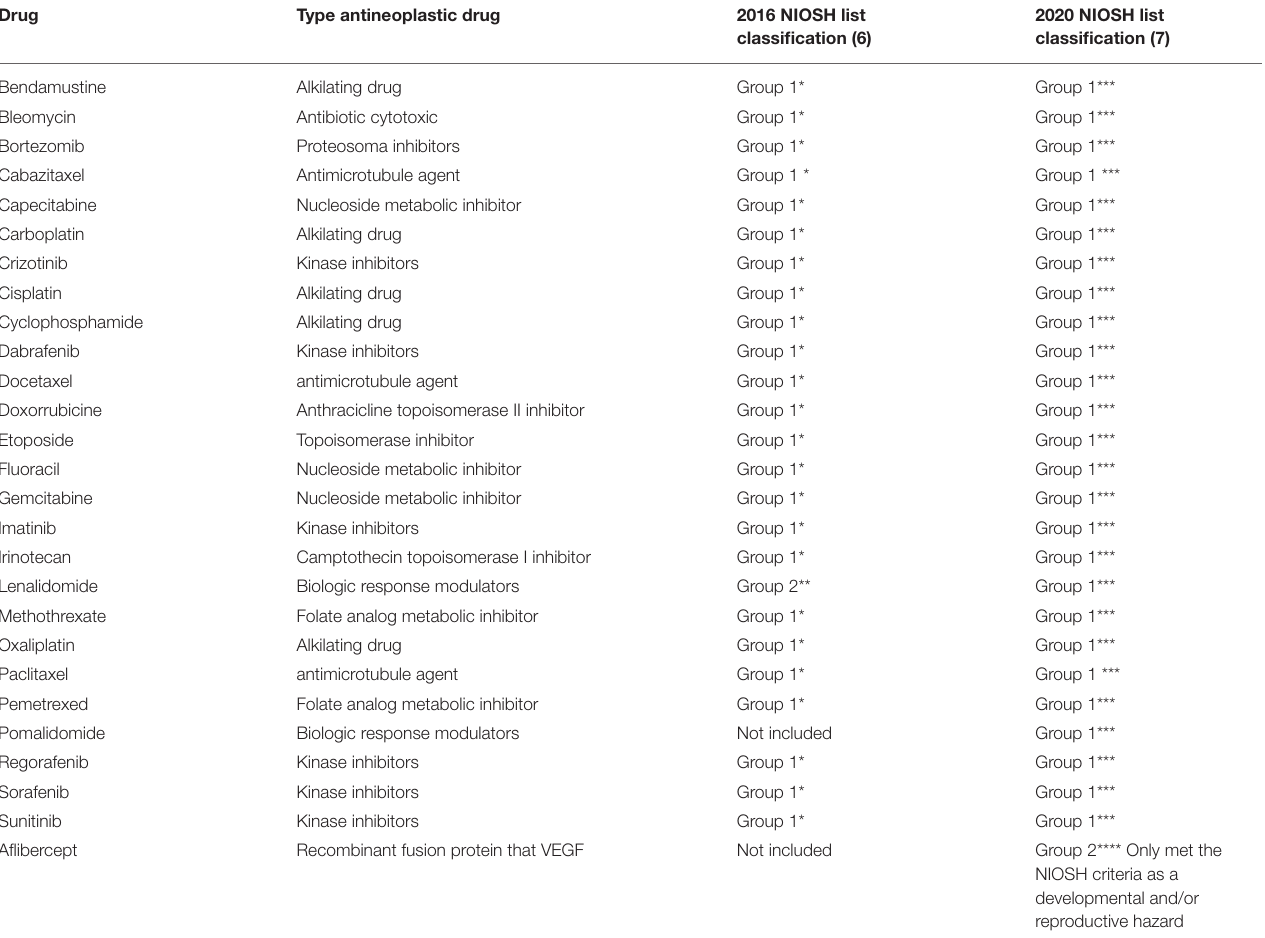
TABLE 1 | 2021 list of hazardous antineoplastic drugs (allergy department at the Ramón y Cajal University Hospital).